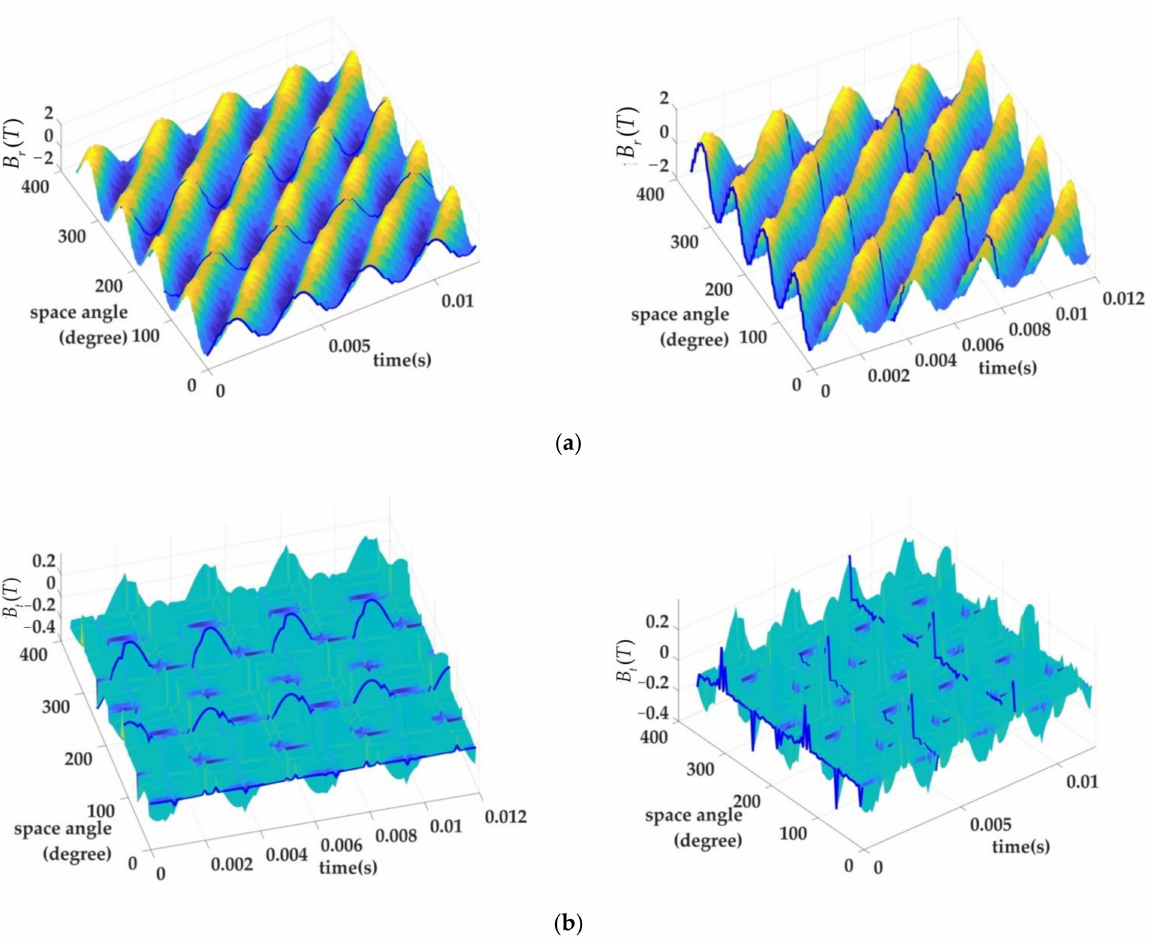
Figure 6. The three-dimensional spatiotemporal characteristics of air-gap magnetic field with mixed eccentricity. ( a ) The spatiotemporal distribution of radial component; ( b ) the spatiotemporal distribu- tion of tangential